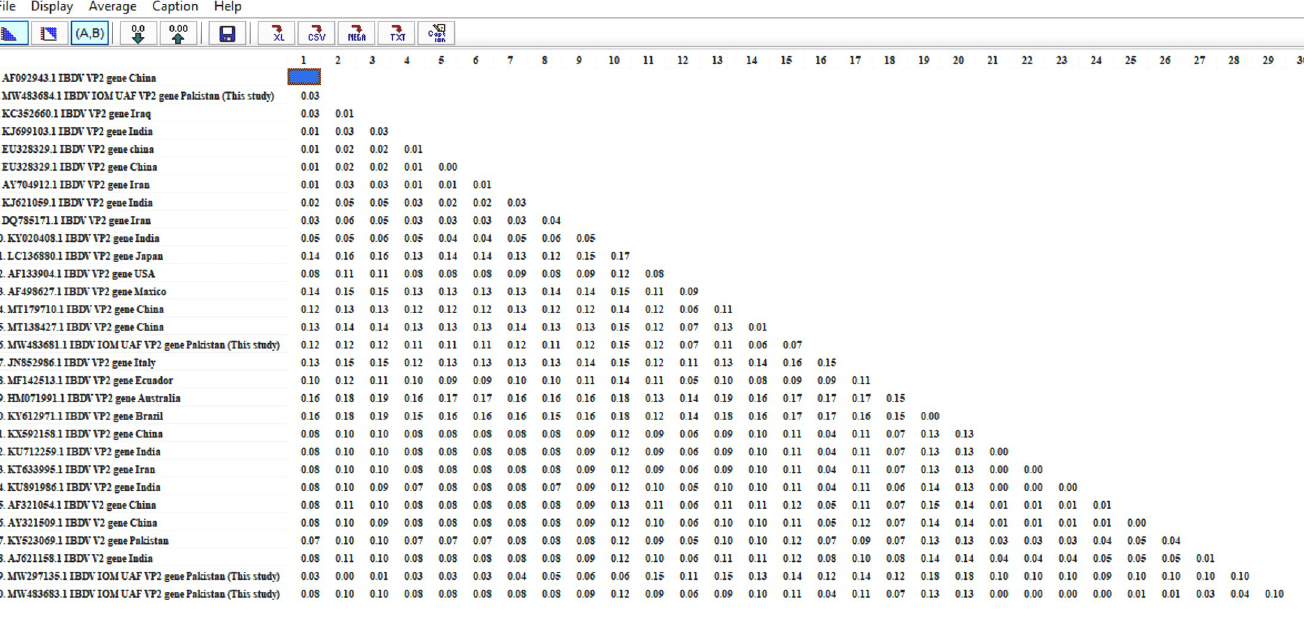
Fig 5. Estimates of evolutionary divergence between